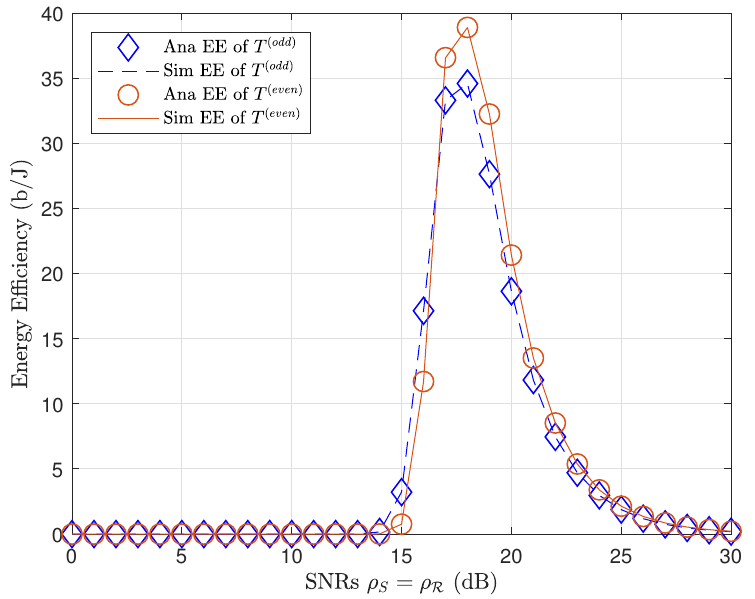
Figure 7. EE of a MIMO network (odd transmission block) compared to a massive MIMO network (even transmission